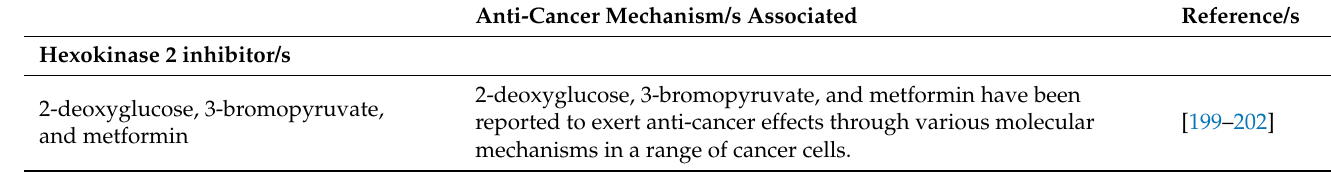
Table 1. Small molecules that inhibit the activity of key glycolytic enzymes and their anti-cancer mechanism in brief.